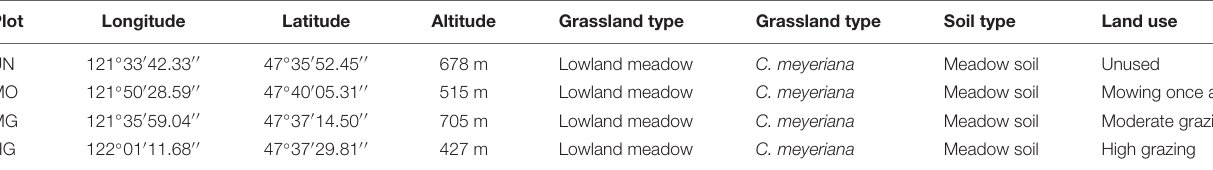
TABLE 1 | Basic information on the test sites. Plot Longitude Latitude Altitude Grassland type Grassland type Soil type Land